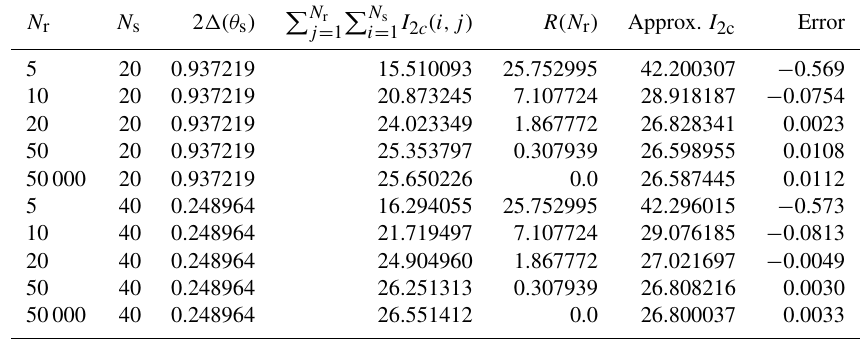
Table 2. Terms in Eq. (20) for s = 0 . 2 and θ 0 = 0. Exact value of I 2c = 26 . 889628. The error is the relative error. N r N s 2 (cid:49) ( θ s